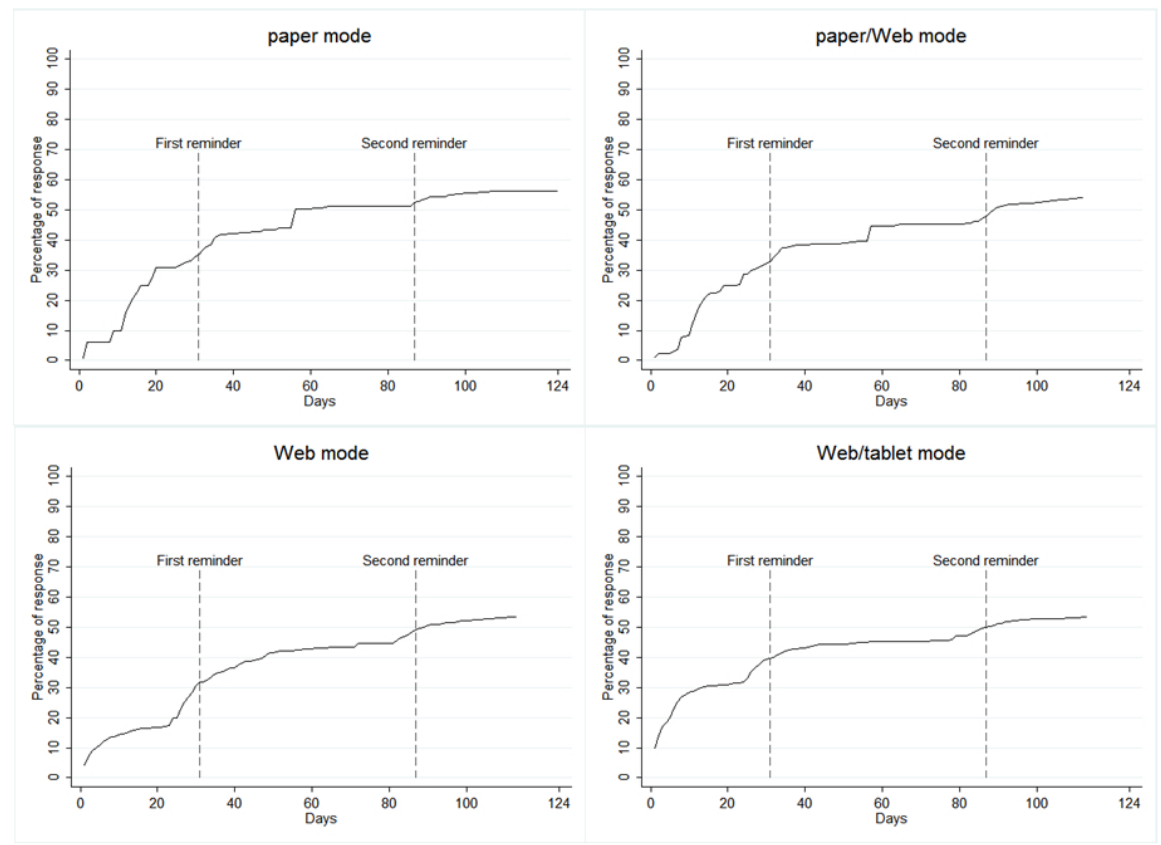
Figure 1. Percentage of received questionnaires by days for the paper (paper-based questionnaire only), paper/Web (paper- and/or Web-based questionnaire), Web (Web-based questionnaire only), and Web/tablet (Web-based questionnaire with tablet computer incentive within 14 days of invitation) modes in the Danish 2011 NordChild questionnaire